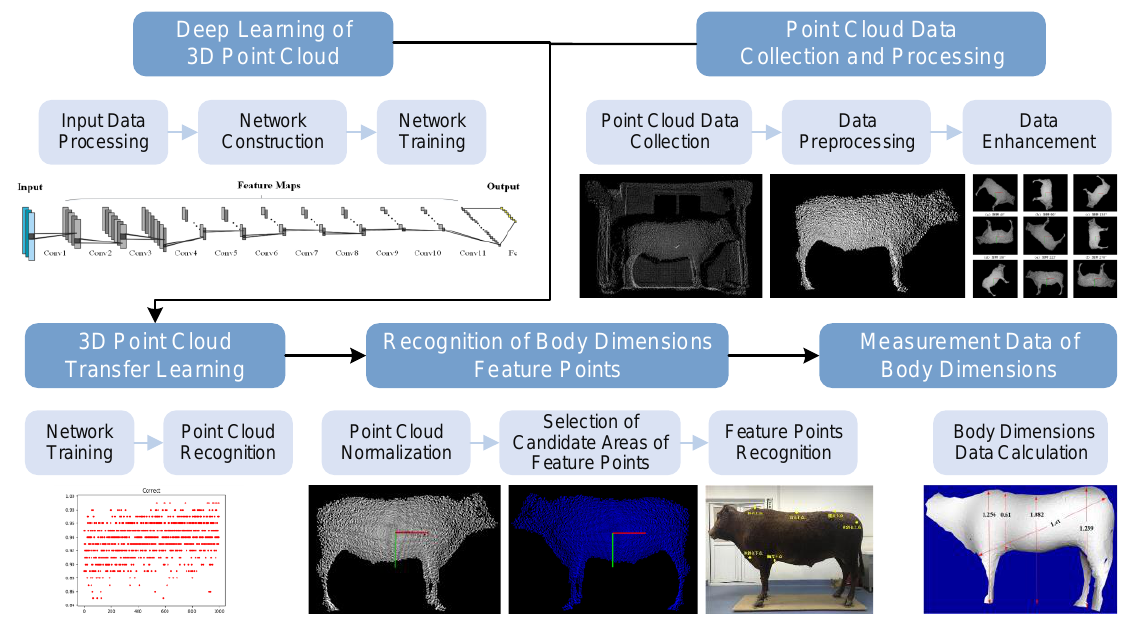
Figure 1. Flowchart of body dimensions measurement of Qinchuan cattle with transfer learning from LiDAR sensor.